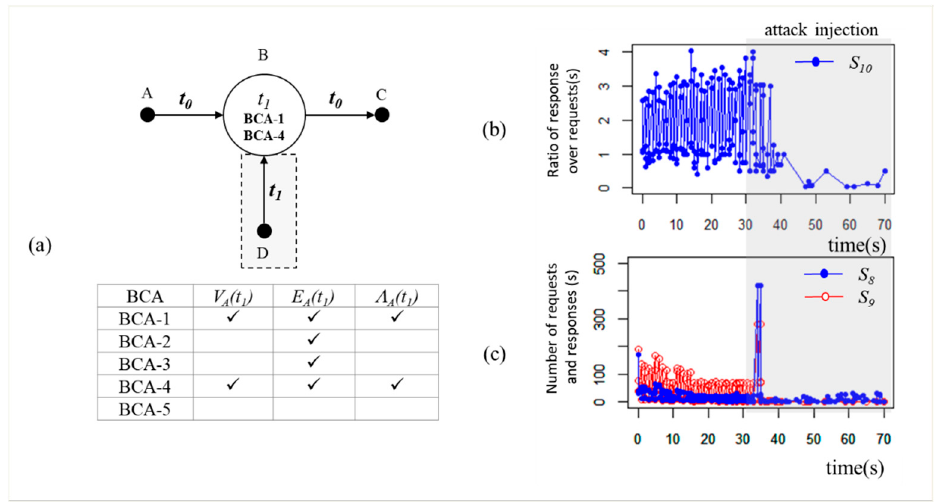
Figure 7. ( a ) Network structure of Scenario 1 and the BCA status of host B. ( b ) Experimental results of S 10 . ( c ) Experimental results of S 8 and S 9 .